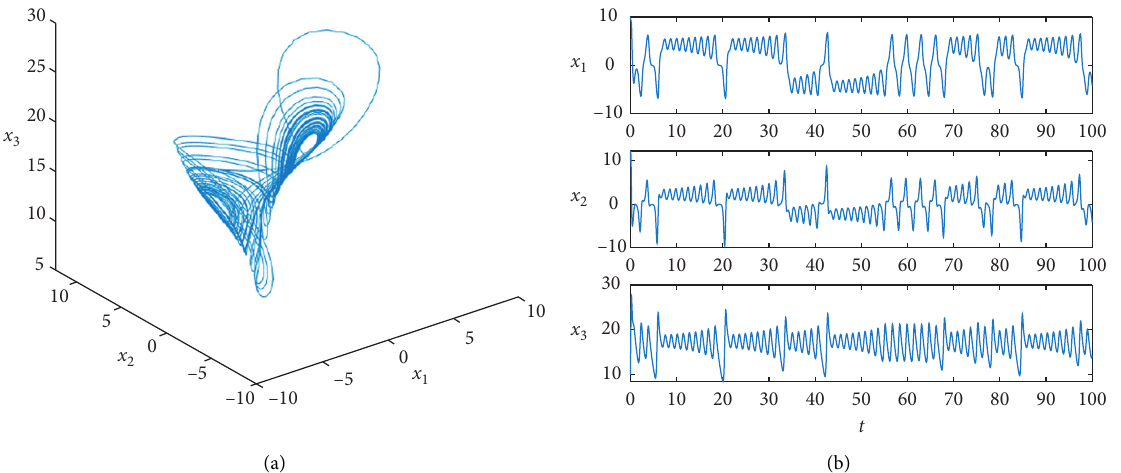
, x ,x ) T � ( 10 , 10 , 10 ) T . (a) 3D phase portraits. (b) Time 1 2 3